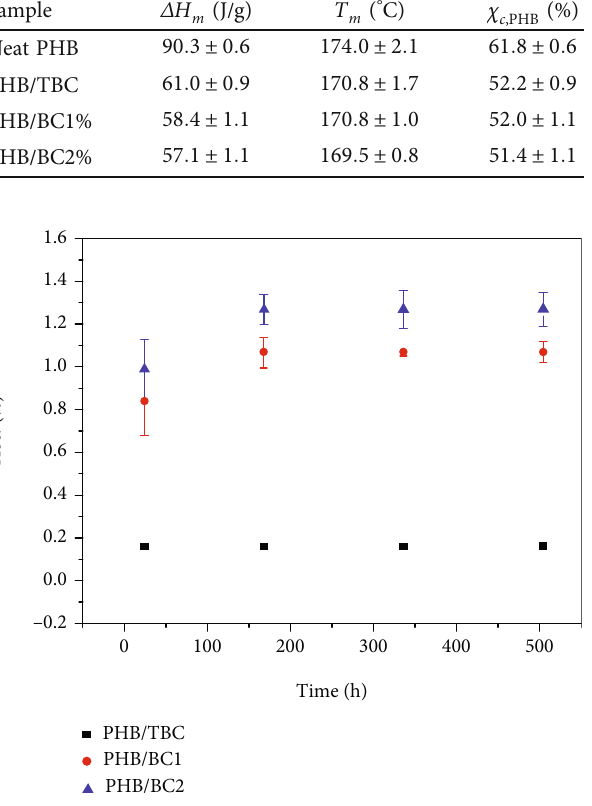
Figure 3: Water absorption for plasticized PHB/TBC sample and its biocomposites at di ff erent